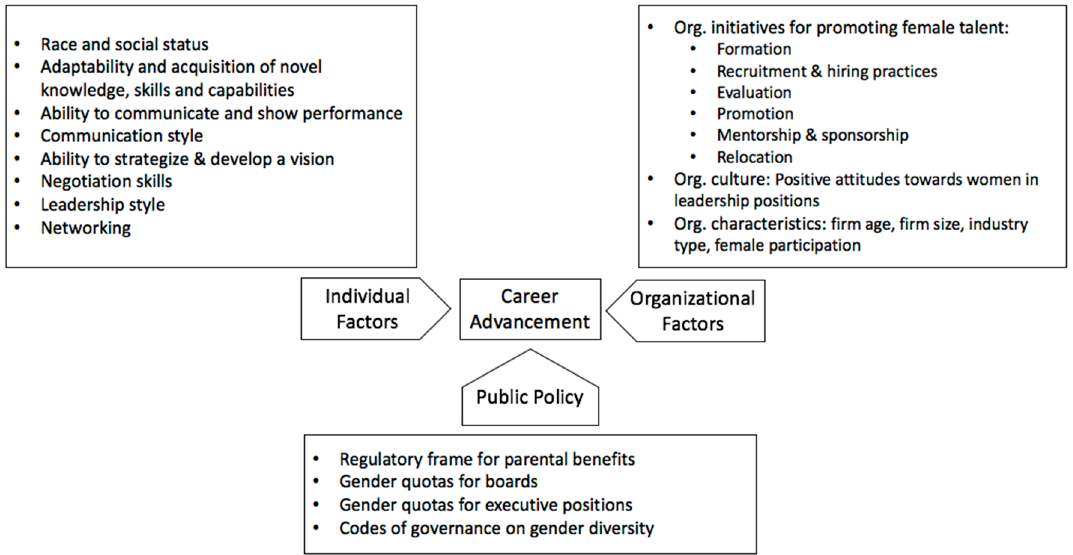
Figure 3. Factors that facilitate the advancement and promotion of female talent toward senior management. Source: Salvaj and Kuschel (forthcoming).